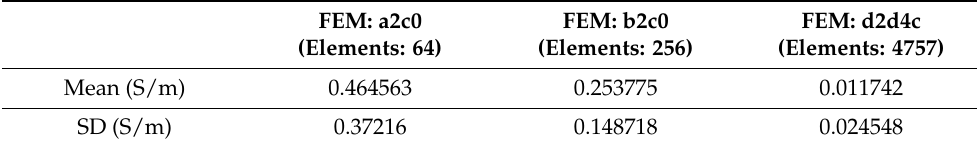
Table 2. Calculated mean and standard deviation (SD) of obtained changes of conductivity by varying FEM models considering a carrot slice in the EIT domain.